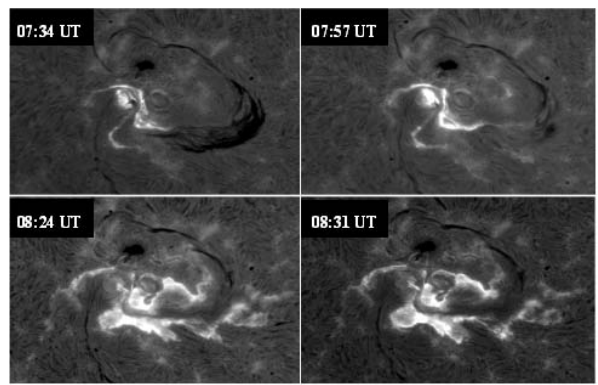
Fig. 2. Flare in H α observed at Udaipur Solar Observatory on 18 November 2003 in NOAA AR 10501. The flare associated CME re- sulted in the strongest geomagnetic storm of the current solar cycle with D st index reaching −